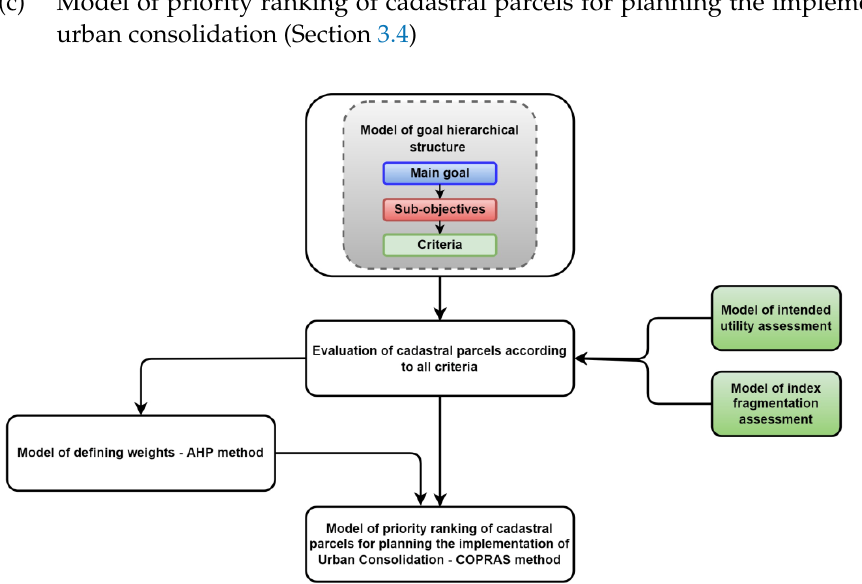
Figure 1. Priority ranking of cadastral parcels for planning the implementation of urban consolida- tion